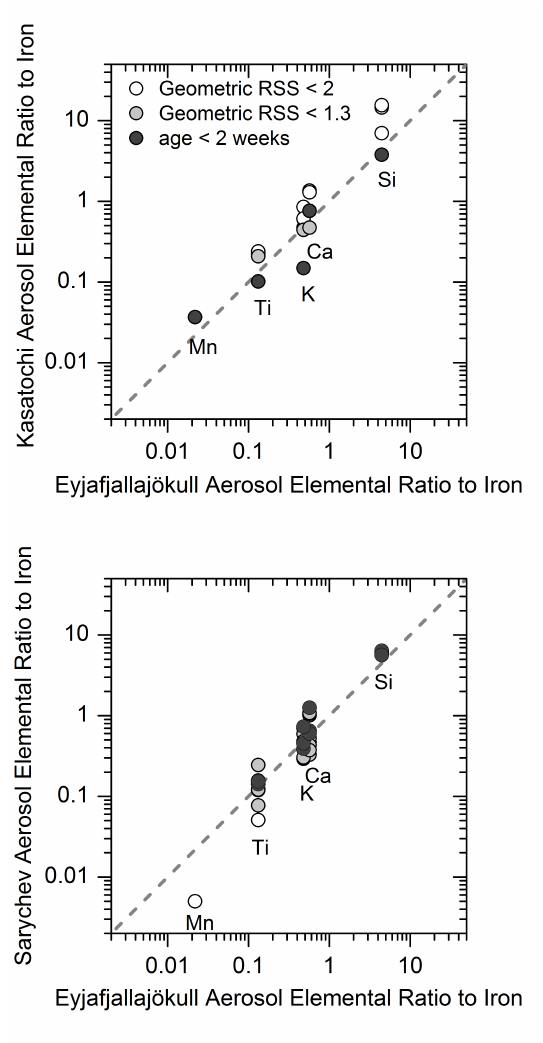
Fig. 4. Elemental ratio to iron in aerosol samples collected follow- ing eruptions of Sarychev and Kasatochi vs. geometric mean of vol- canic aerosol collected in the volcanic cloud from Eyjafjallaj¨okull. The dashed line indicates equal ratio. Samples with a Residual Sum of Squares (RSS) of less than two are included in the figures. Sam- ples collected less than two weeks after the start of the eruptions are marked by dark